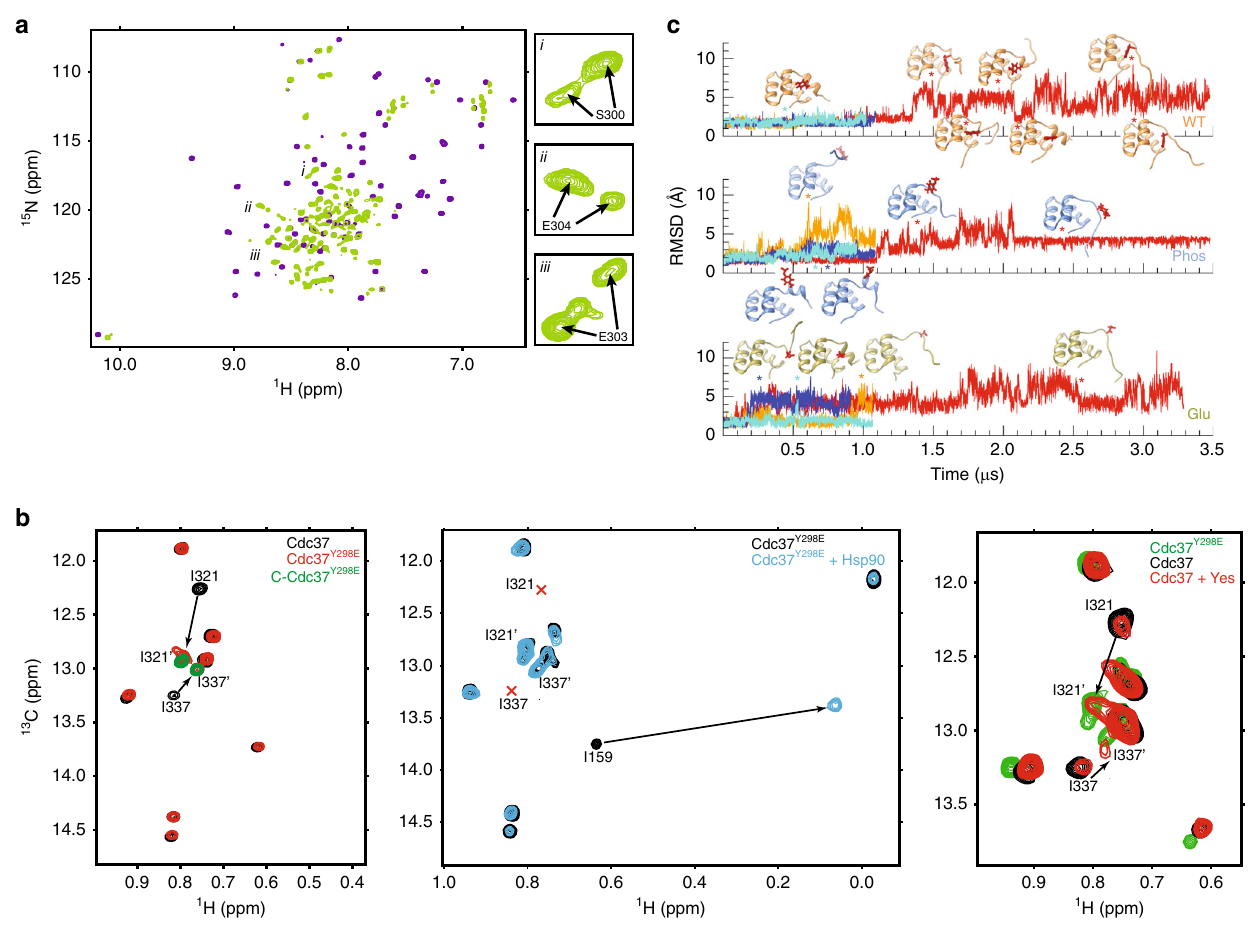
Fig. 2 Phosphorylation of C-Cdc37 induces partial unfolding. a Overlay of the 15 N-HSQC of Y298E (green) and wild-type C-Cdc37 (purple) with selected expansions shown on the right. b Selected regions (Ile δ ) from 13 C-HMQC spectra of Cdc37 constructs. Left: overlay of full-length wild-type Cdc37 (black), full-length phosphomimetic mutant Cdc37 Y298E (red), and C-domain phosphomimetic mutant C-Cdc37 Y298E (green). Middle: overlay of free Cdc37 Y298E (black) and in the presence of one equivalent deuterated Hsp90 α (cyan). The red marks indicate the positions of I321 and I337 signals in wild-type Cdc37. Right: overlay of Cdc37 (black) and Cdc37 in the presence of 15- μ g Yes acquired in “ phosphorylation ” buffer (red), together with Cdc37 Y298E (green). c Backbone rmsd for unmodi fi ed (top), phosphorylated (middle), and C-Cdc37 Y298E (bottom). Simulations at 300 K are shown in dark and light blue, and at 310 K in orange and red. Stars mark the time intervals from which snapshots were